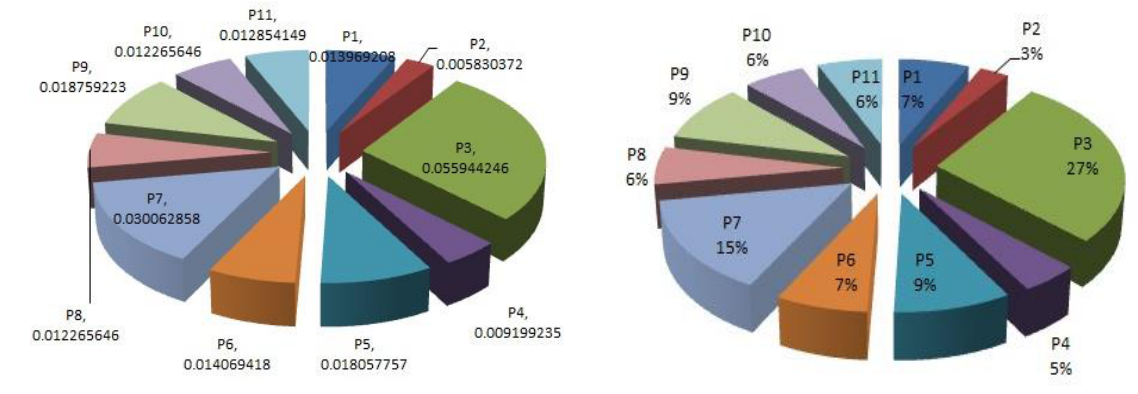
Figure 2: Breakdown of carbon footprint of welding processes.